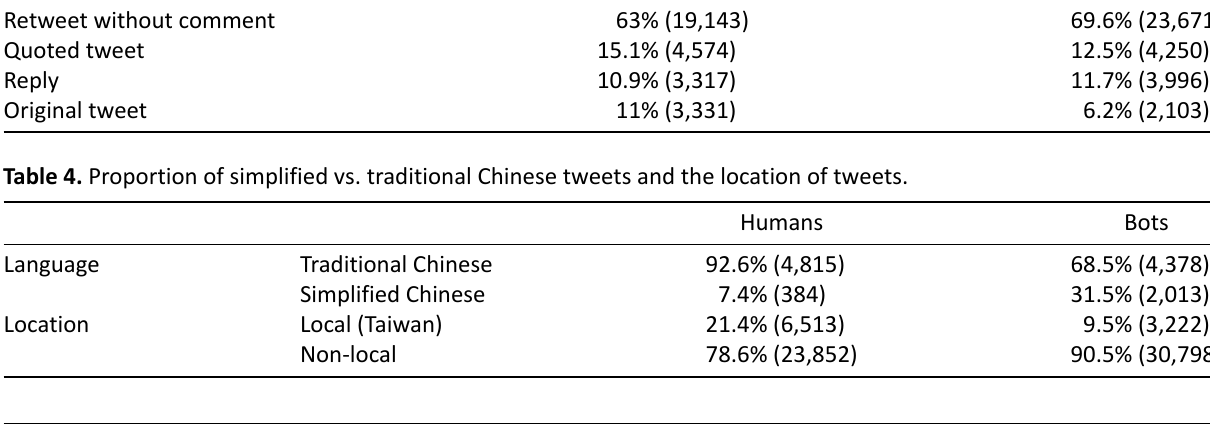
Table 3. Difference in tweet type distribution between humans and bots (top and bottom 10% by Botscore). Type of tweet